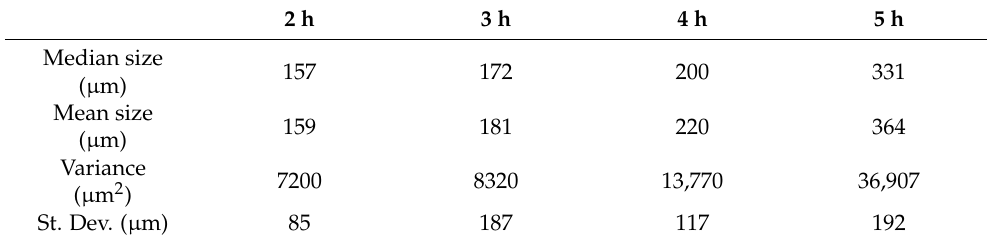
Table 1. Dependency of size distribution characteristics on gelation time.